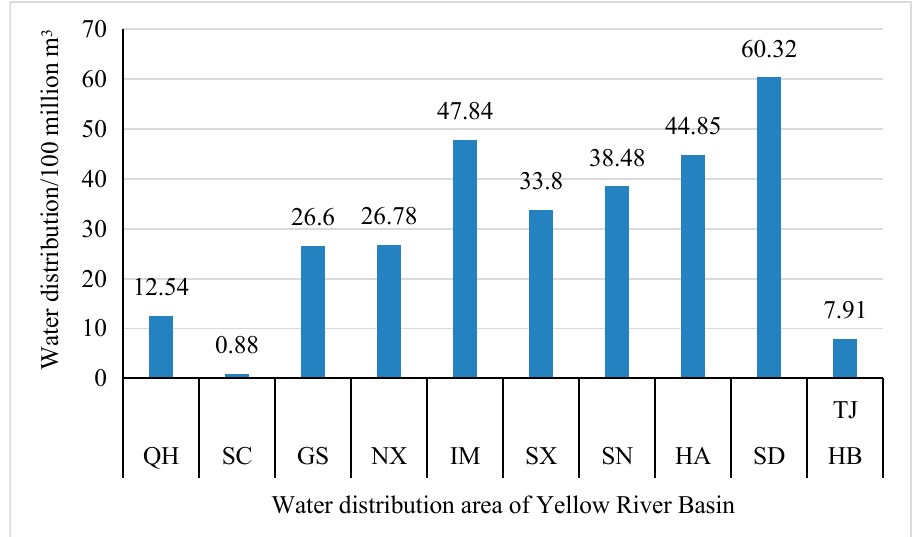
Figure 9. A water distribution scheme for the Yellow River, with a water supply capacity of 30 billion m 3